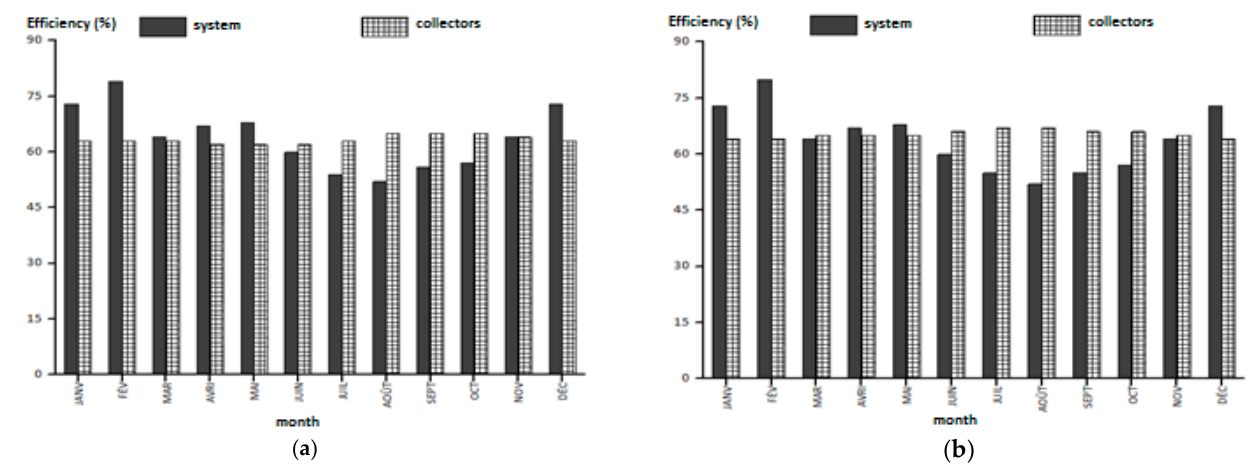
Figure 12. ( a ) Flat plate collector, ( b ) evacuated tube collector (efficiencies).